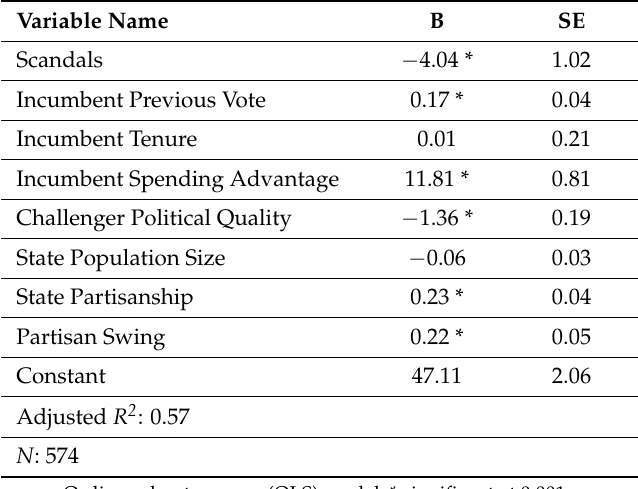
Table 5. The impact of scandals on incumbent vote share,